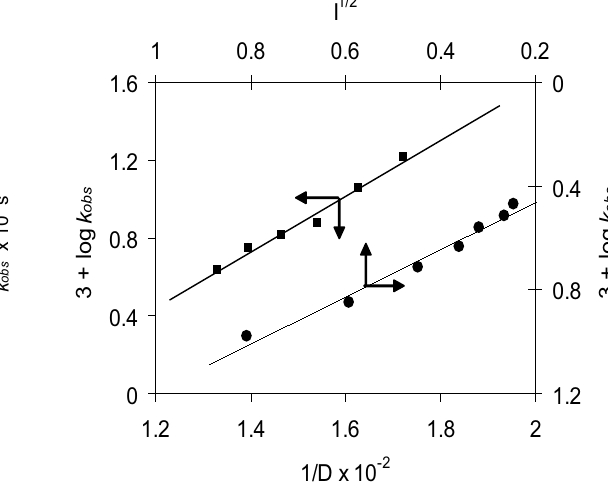
Figure 5. Effect of ionic strength and dielectric constant of the Figure 4. Plots of k versus [L-Tyr] 0.77 and k versus [L-Tyr] obs obs medium on oxidation of L-tyrosine by DPC at 298.1 (Conditions outlined in Table 1).